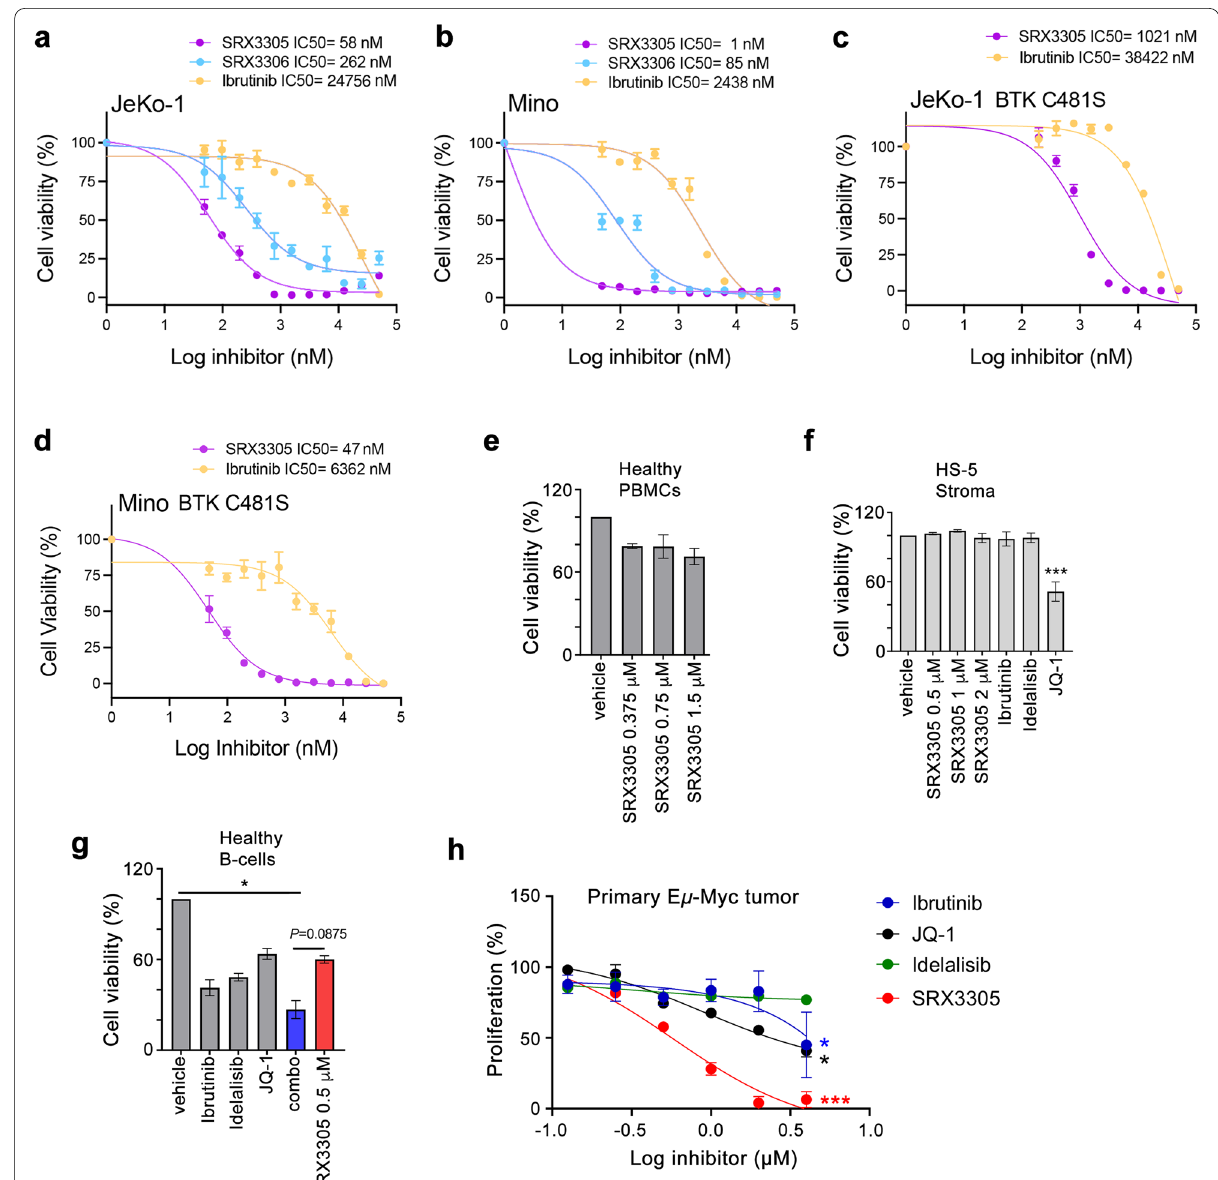
Fig. 2 SRX3305 is cytotoxic to MCL cells. a-d Anti‑proliferative activity of JeKo‑1, Mino, JeKo‑1 BTK C481S and Mino BTK C481S MCL cell lines treated with increasing concentrations of indicated inhibitors. Error bars represent mean SEM ( n independent 3 experiments). e PBMCs from healthy ± = subjects ( n 4) were treated with increasing concentrations of SRX3305 or DMSO vehicle for 48 h. Viability was assessed via MTS assay and results = are normalized to vehicle. f Human HS‑5 bone marrow‑derived stromal cell line was treated for 72 h with DMSO vehicle, indicated concentrations of SRX3305, 1 μM Ibrutinib, 1 μM Idelalisib or 1 μM JQ‑1. Viability was assessed via MTS assay and results are normalized to vehicle. Results (mean SEM) are given from n 4 independent experiments. *** P < 0.001 vs. vehicle. g B‑cells were purified from healthy subject PBMCs ( n 3) using ± = = negative selection kit. Normal B‑cells were then incubated with DMSO vehicle, 0.5 μM Ibrutinib, 0.5 μM Idelalisib, 0.5 μM JQ‑1, a combination (combo) of the single inhibitors (Ibrutinib, Idelalisib, and JQ1 each at 0.5 μM), or 0.5 μM SRX3305. After 48 h, viability was assessed by MTS. Results (mean SEM) were normalized to vehicle. * P < 0.05 vs. vehicle and as indicted for combo vs. SRX3305. h Splenocytes isolated from morbid E μ ‑Myc ± mice ( n 4) were stimulated ex vivo with PMA/Ionomycin and treated with DMSO vehicle or increasing inhibitor concentrations as indicated. After = 48 h, proliferation was assessed by MTS and normalized to vehicle. Results are shown as (mean SD). Dose‑dependent decrease in cell proliferation ± is observed with symbols denoting significance (* P < 0.05, *** P <